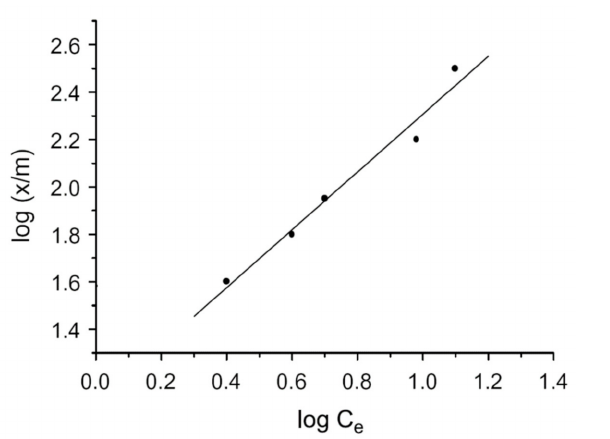
Figure 9. Freundlich isotherm of Ni (II) adsorption /adsorbent amount 5–50 mg per 50 mL, pH 2, time of treatment 1 h/.